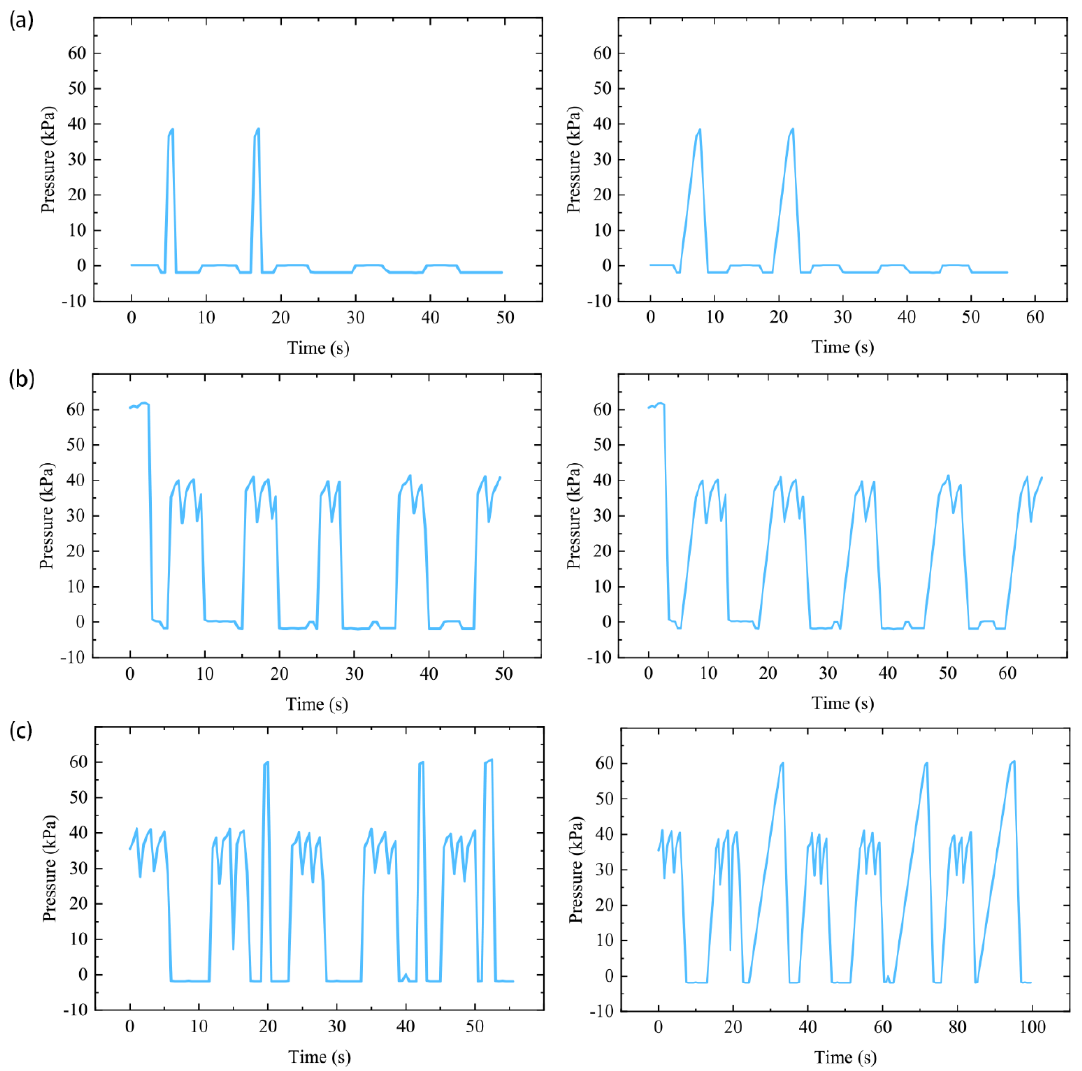
Figure 15. Actual air pressure among the motion sequences. The left graphs show the results of that when the time is out of consideration; the right graphs show the results of that when time is taken into account. ( a ) The results for motion sequence RE. ( b ) The results for motion sequence RS. ( c ) The results for motion sequence SF.